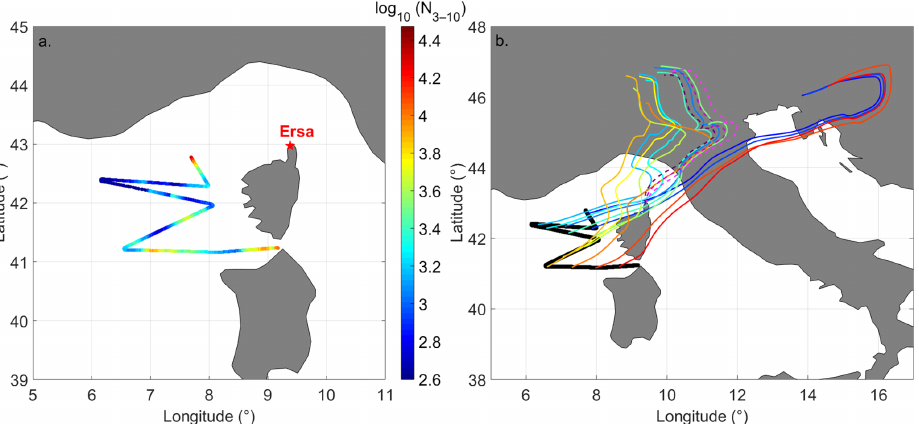
Figure 12. (a) N 3 − 10 above the threshold value along the flight path; (b) air mass back-trajectories (solid lines) calculated along the flight path (black line) every 10min (solid colored lines) together with the back-trajectories of air masses arriving in Ersa each hour during the same time period (dashed lines) during the 1 August